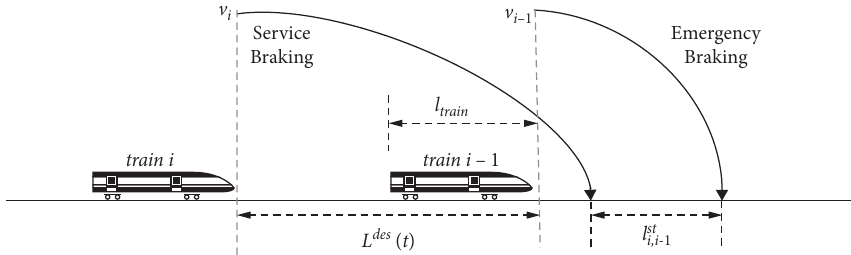
Figure 4: Trains simultaneously running in